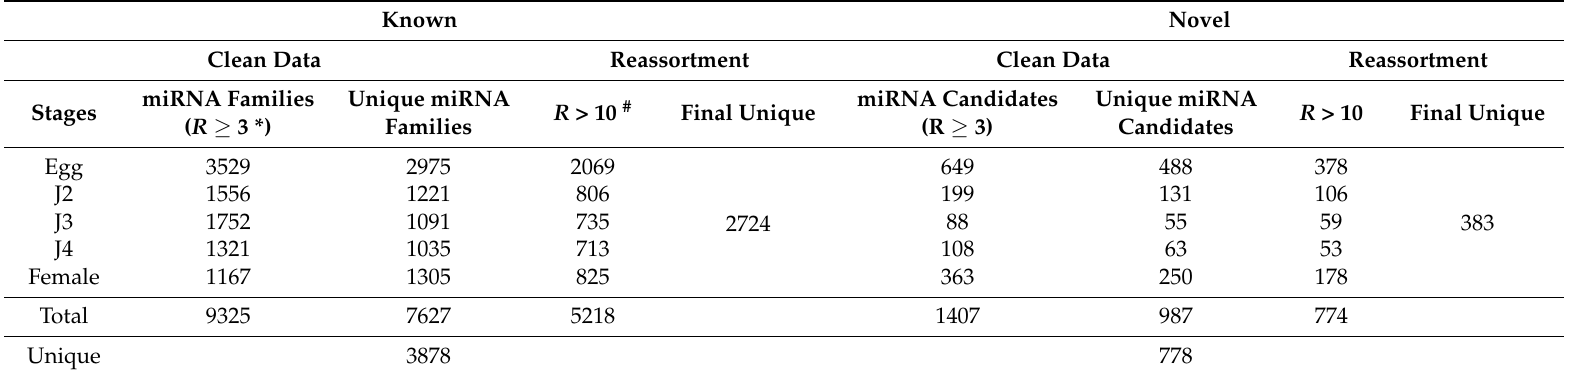
Table 2. Statistics of miRNA combining all developmental stages.